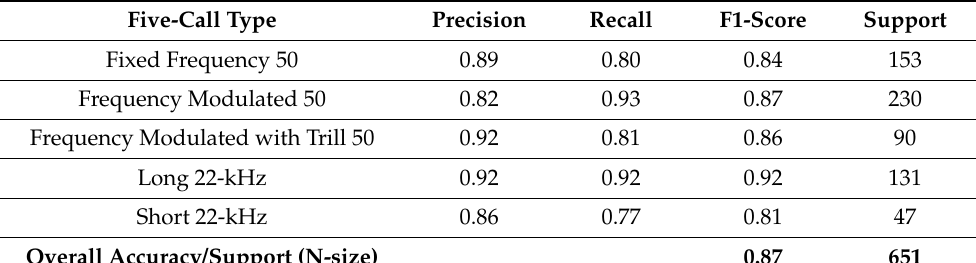
Table 5. Evaluation of the five-call composite classification model performance on the training